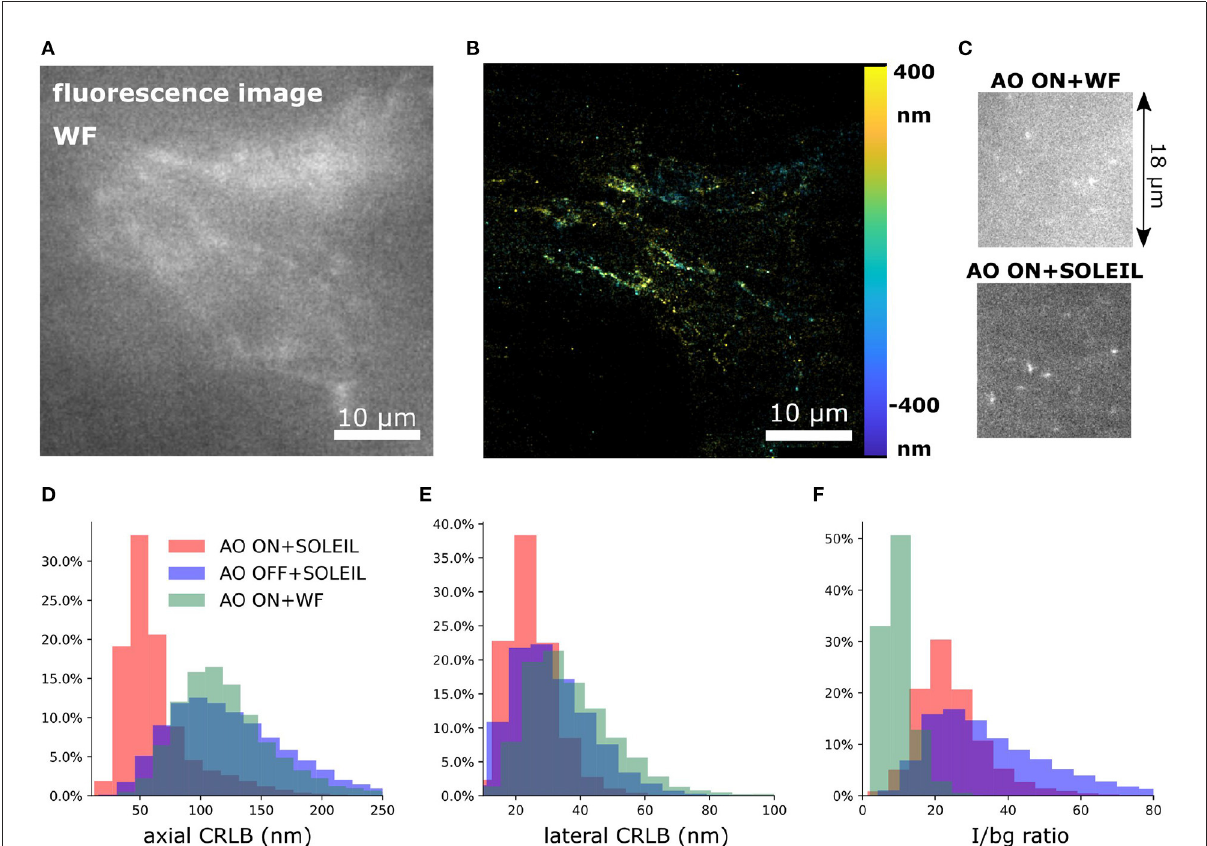
FIGURE13 3D SMLM of a single neuron in a whole adult Drosophila brain. (A) The fluorescence signal of a part of the dendritic field of the single neuron with widefield microscopy. The data is acquired at a depth of 30 µ m. (B) 3D SMLM reconstruction with SOLEIL and AO correction. (C) Raw camera image with widefield microscopy and SOLEIL microscopy. (D–F) Quantitative comparison of the axial CRLB, lateral CRLB, and I/bg ratio. The reconstruction images of AO OFF+SOLEIL and AO ON+WF are in (Figure 14).